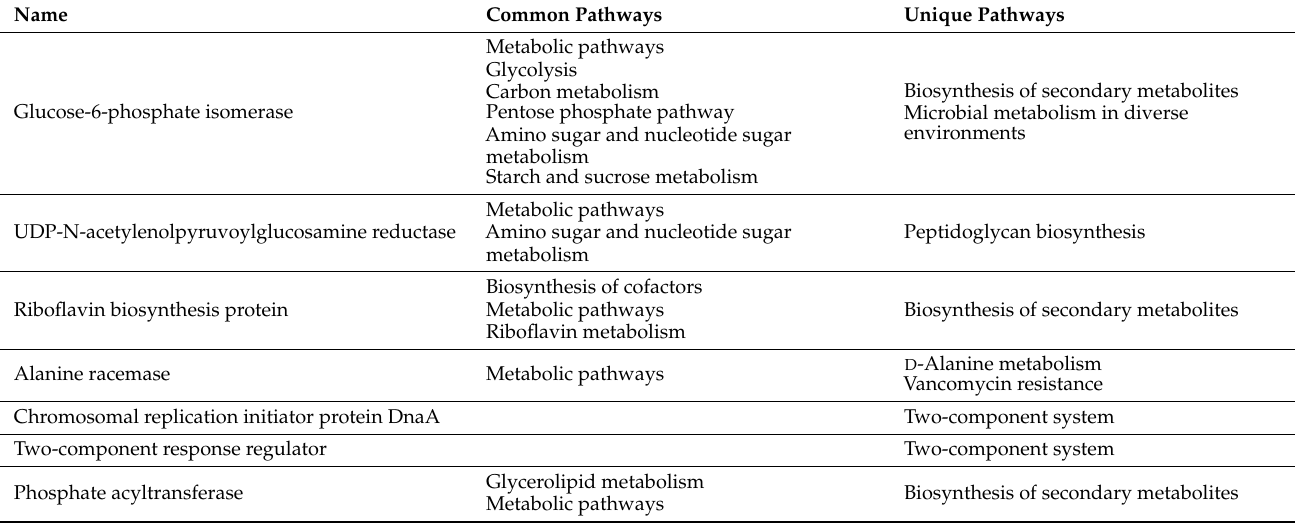
Table 1. Ten cytoplasmic proteins presented in unique metabolic